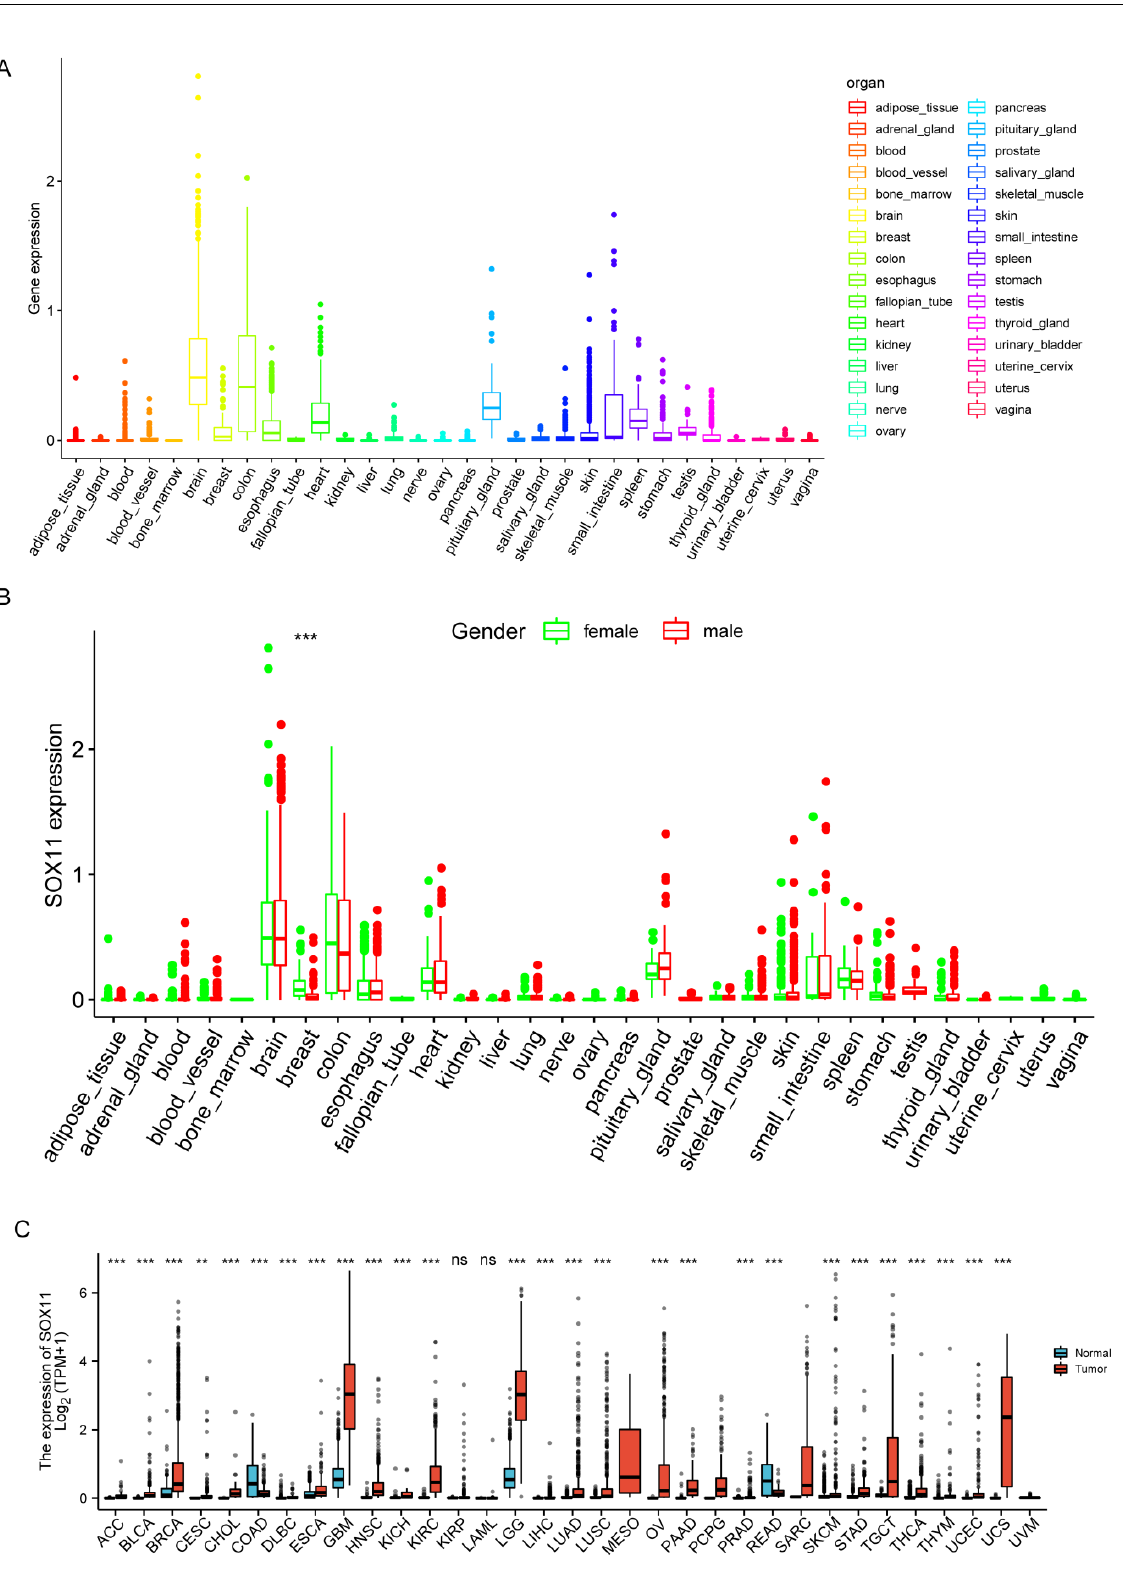
Figure 1. Expression analysis of SOX11 . ( A ) The SOX11 expression in normal tissues from Genotype Tissue-Expression (GTEX) data. ( B ) The SOX11 expression abundances of various tissues in males and females. ***, p < 0.001. ( C ) Differential SOX11 mRNA expression between 33 TCGA cancers and GTEX normal tissues. The red color column represents the cancer samples, and the blue color column represents the normal samples. ns, p ≥ 0.05; **, p < 0.01; and ***, p <